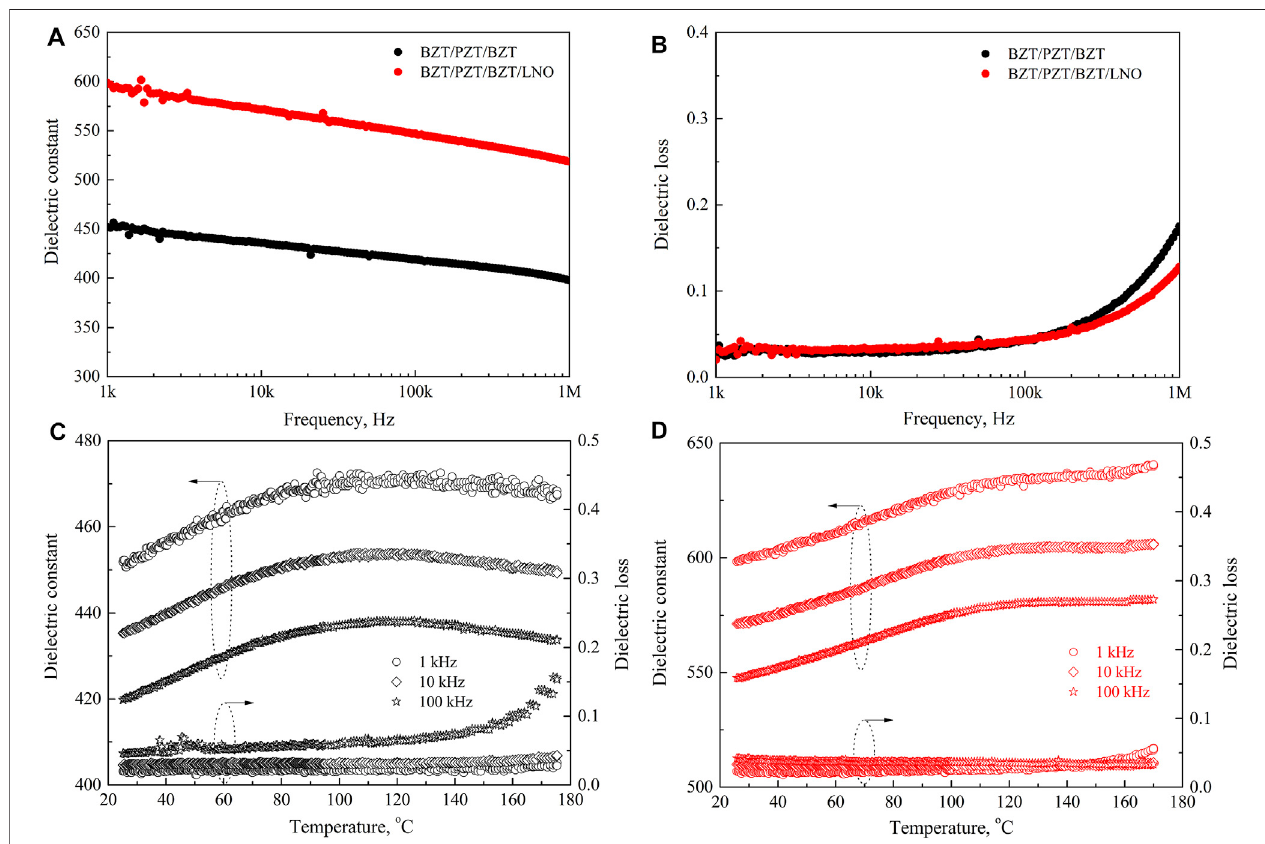
FIGURE 4 | Dependence of dielectric properties on measured frequency and temperature. (A) Dielectric constant. (B) Dielectric loss. (C) BZT/PZT/BZT. (D) BZT/ PZT/BZT/LNO.